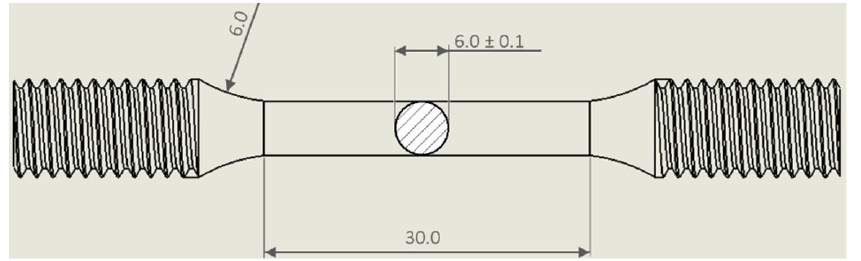
Figure 3. Graphical representation of a cylindrical tensile sample obtained from the as-built billets, where all measurements are expressed in mm (Reprinted from reference [25]).